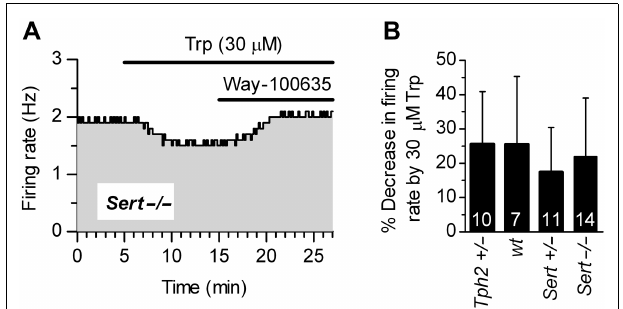
FIGURE 3 |Autoinhibition by endogenous 5-HT synthesized from Trp is conserved across genotypes. (A) Trp (30 μ M) produced a 5-HT 1A receptor-mediated decrease in the firing rate of a 5-HT neuron from Sert − / − mice. Application of a selective 5-HT 1A receptor antagonist, WAY-100635 (50 nM; representative of three experiments) fully antagonized Trp effect, confirming that autoinhibition was mediated by 5-HT 1A autoreceptors. (B) Application of 30 μ MTrp significantly suppressed firing activity of DRN serotonergic neurons in all the genotypes tested ( p < 0.05; Wilcoxon signed rank test). Comparison of the effect ofTrp among genotypes revealed no statistically significant differences among genotypes [ H ( 3 ) = 3.336, p = 0.3427; Kruskal–Wallis test]. Data are shown as mean ± SD.The number of neurons recorded for each genotype